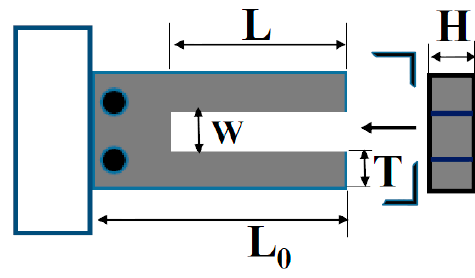
Figure 1. Schematic diagram of QTF.